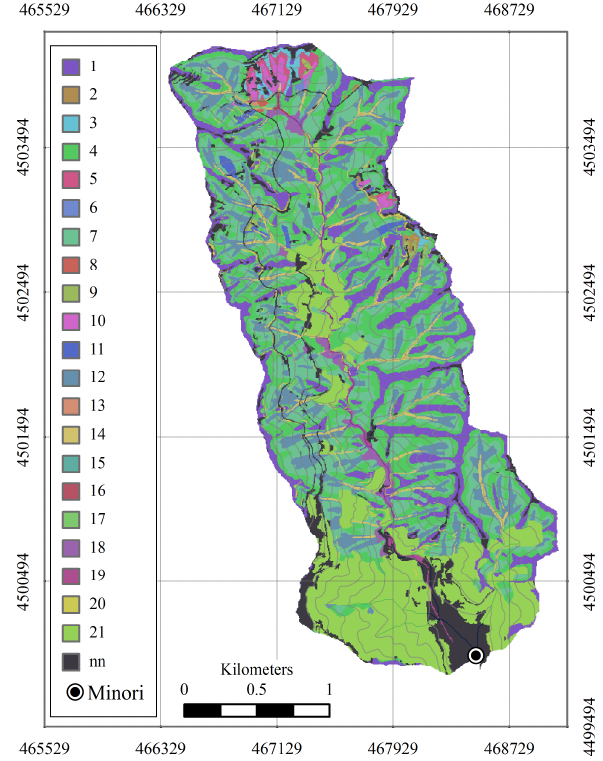
Fig. 5. Map of the geomorphological homogeneous districts (Papa et al., 2011a). The values of the static variables for each of the dis- trict (numbered from 1 to 21) are reported in Table 3; nn =absence Figure 5. Map of the geomorphological homogeneous districts (Papa et al. 2011a). The values 3 of soil cover (e.g. urbanized areas, rocks, streets). of the static variables for each of the district (numbered from 1 to 21) are reported in Table 3; 4 nn = absence of soil cover (e.g. urbanized areas, rocks, streets). 5